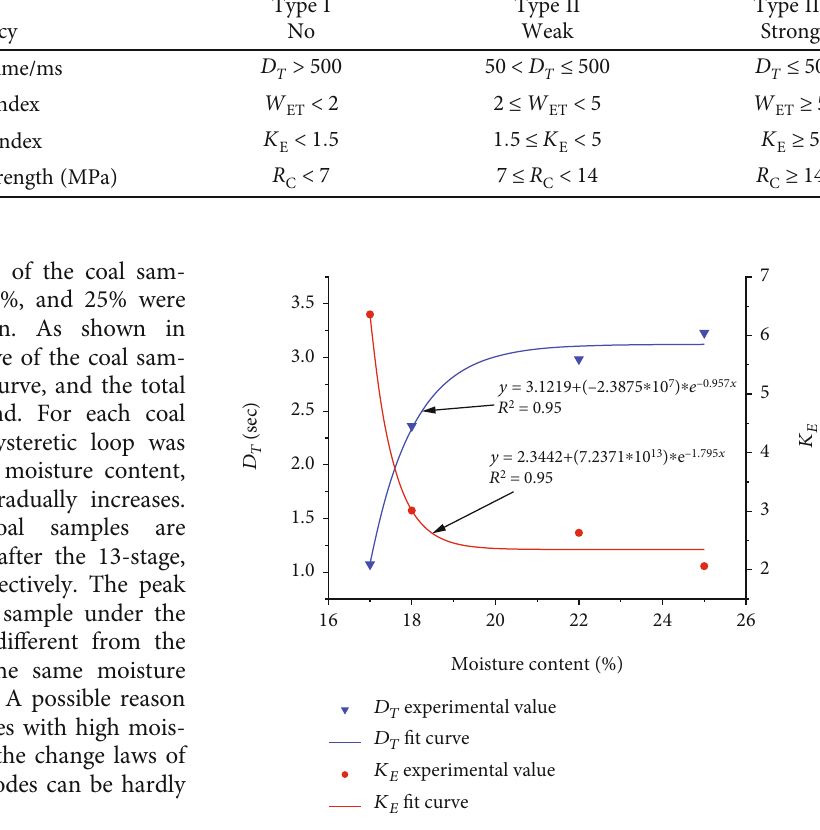
Figure 7: Fitted curves of dynamic failure time and impact energy index of coal samples with di ff erent moisture